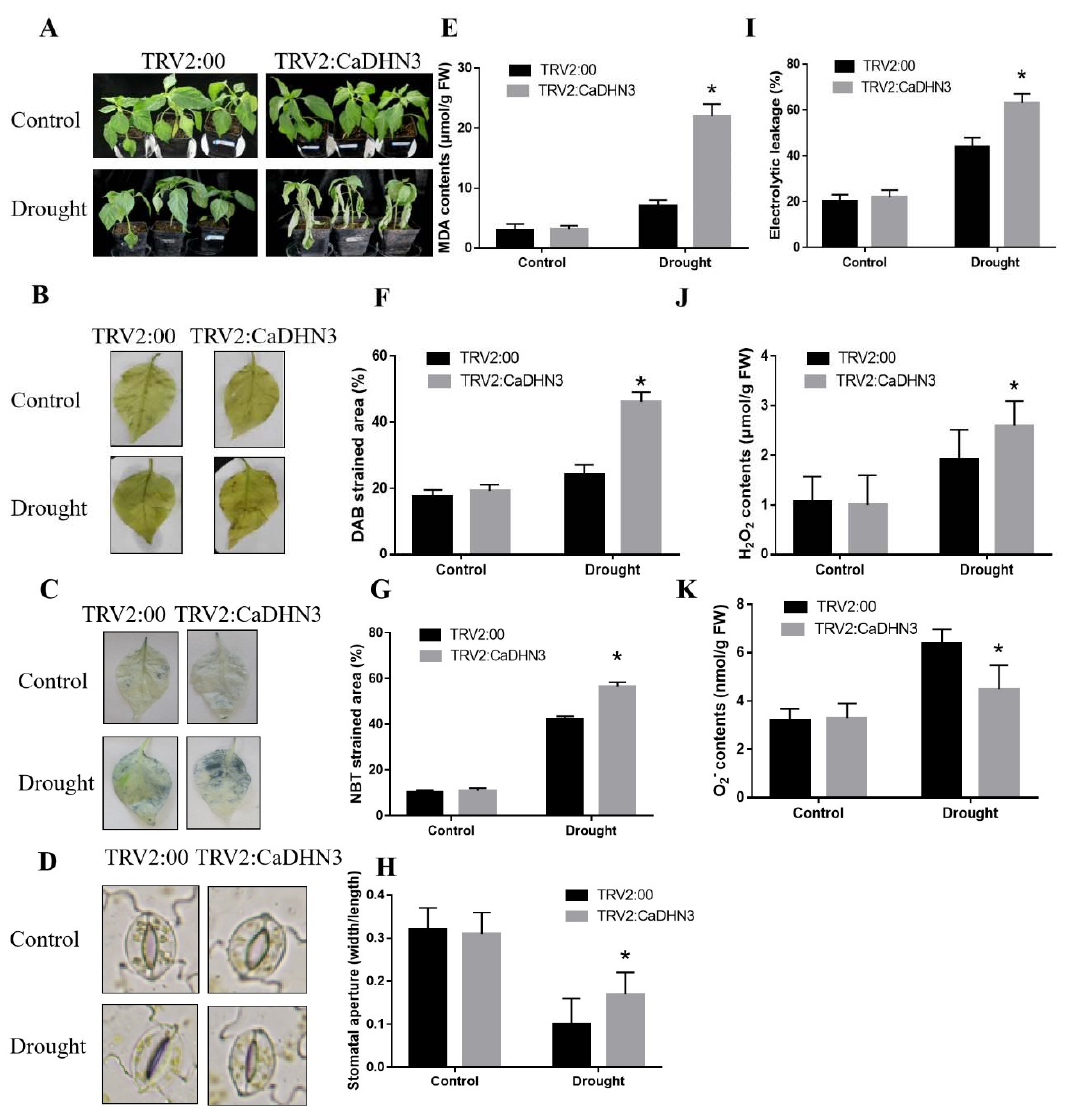
Figure 3. Physiological indices measurement under drought stress. ( A ) Phenotypes of silenced pepper plants under drought Scheme. ( B ) DAB staining. ( C ) NBT staining. ( D ) Stomatal conductance. ( E ) MDA content. ( F ) % DAB strain areas. ( G ) % NBT strain areas. ( H ) Stomatal aperture. ( I ) Relative electrolyte leakage. ( J ) H 2 O 2 contents ( K ) O 2 •− contents. Mean and S.D. values were obtained from three independent experiments. Asterisks indicate statistical significance (* p < 0.05, Student’s test) compared to